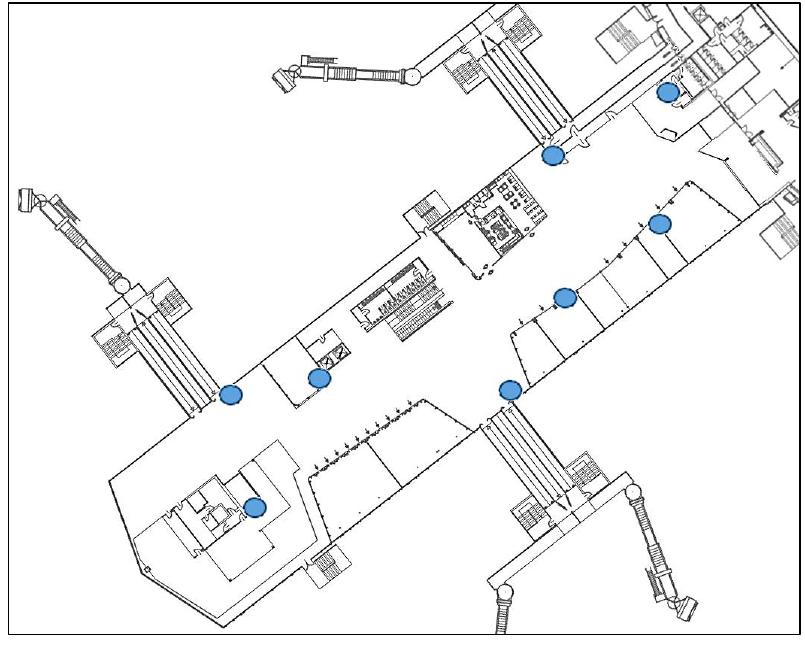
Figure 6. Cagliari airport